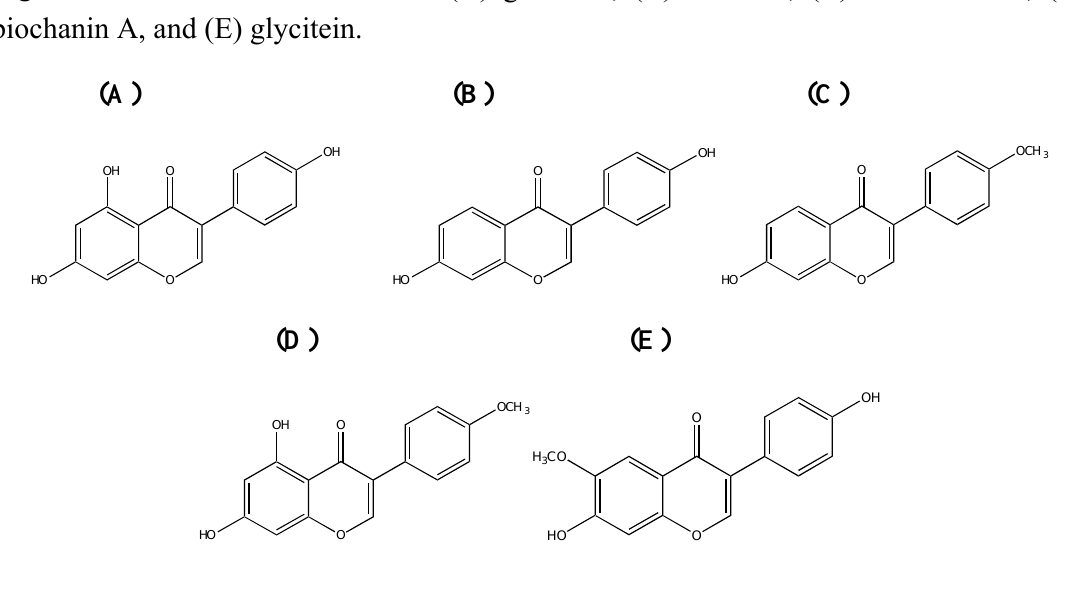
Figure 2. Structure of isoflavones: (A) genistein, (B) daidzein, (C) formononetin,